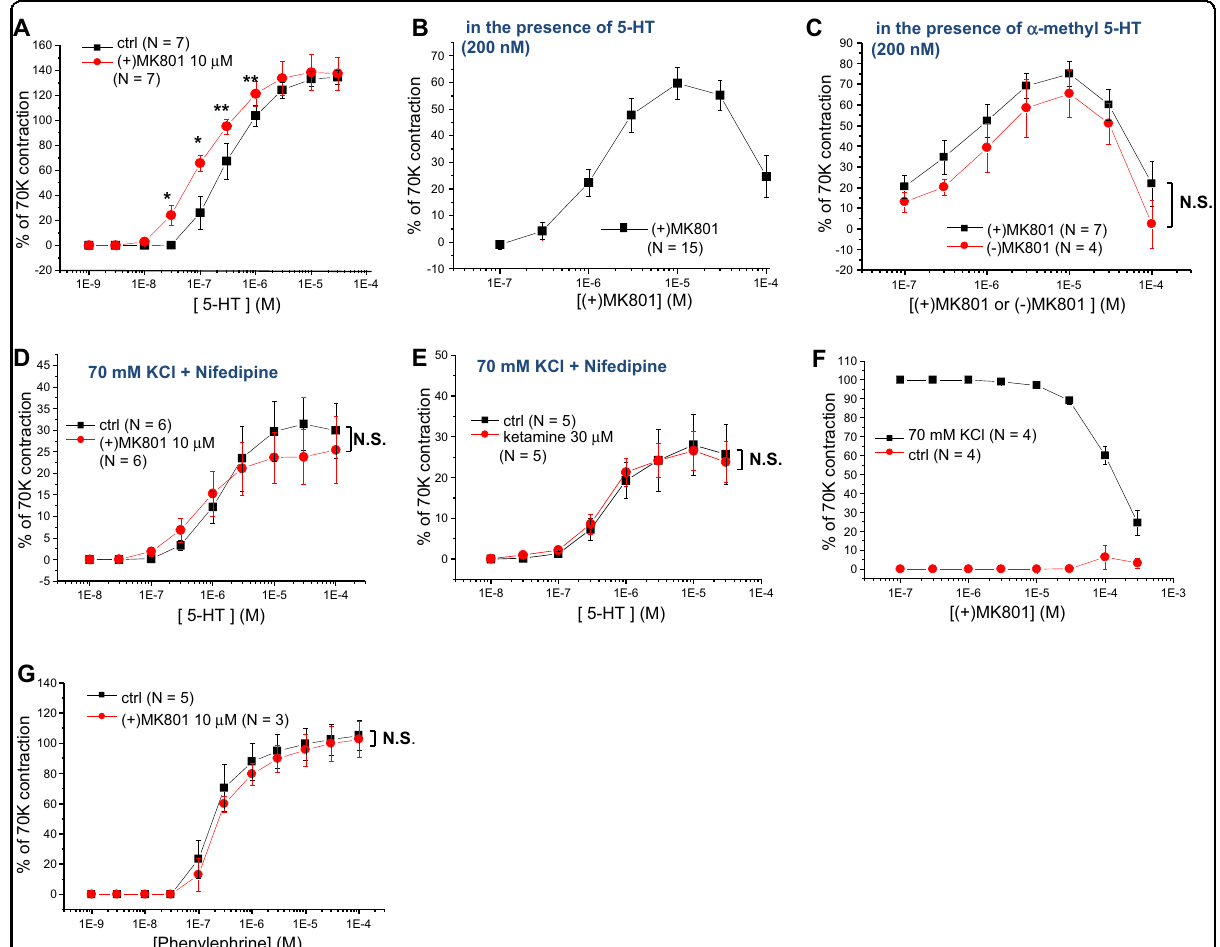
Fig. 1 Facilitation of 5-HT 2A R-mediated arterial contractions by MK801 and ketamine. a Concentration-response curves (CRCs) of 5-HT-induced rat mesenteric arterial contractions in the absence and presence of MK801. b CRC of MK801-induced rat mesenteric arterial contractions in the presence of a physiological concentration (200 nM) of 5-HT. c CRC of ( + ) and ( − ) MK801-induced rat mesenteric arterial contractions in the presence of 200 nM of α -methyl 5-HT, a selective 5-HT 2A R agonist. d Membrane potential (E m )-independent CRCs of 5-HT-induced rat mesenteric arterial contractions in the absence and presence of MK801 after pretreatment with 70 mM KCl and nifedipine (1 µM). e E m -independent CRCs of 5-HT- induced rat mesenteric arterial contractions in the absence and presence of ketamine after pretreatment with 70 mM KCl and nifedipine (1 µM). f CRC of MK801-induced rat mesenteric arterial contractions in the absence and presence of high (70 mM) KCl. g CRCs of phenylephrine-induced rat aorta contractions in the absence and presence of MK801. N in parentheses indicates the number of animals examined. * p < 0.05; ** p < 0.01; N.S. not signi fi